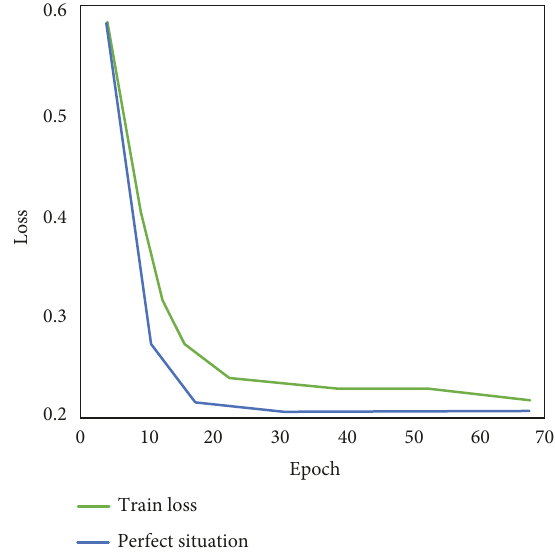
Figure 4: The relationship between the ideal value and the loss value of the training model.